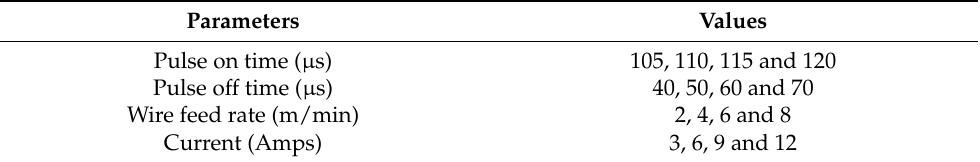
Table 3. WCEDM process parameters.